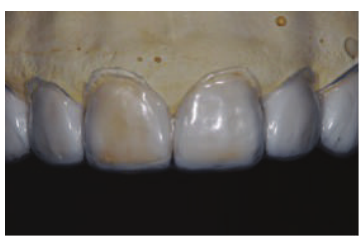
Figure 1: Clinical photograph representing the preoperative facial view with presence of diastemas.